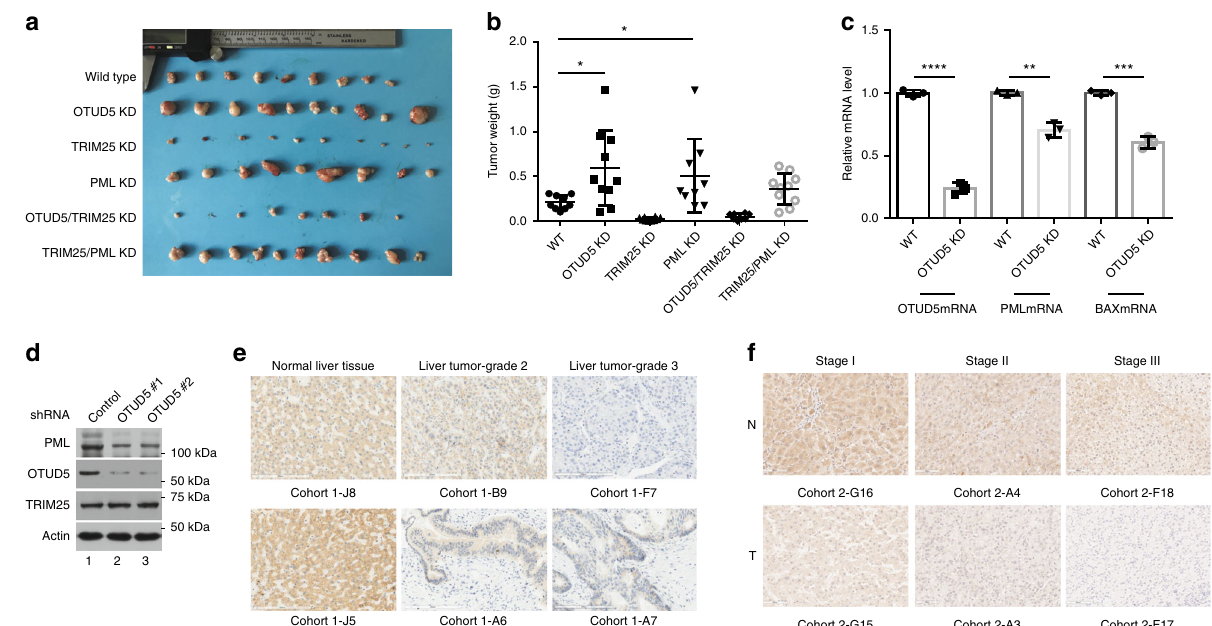
Fig. 7 The OTUD5-TRIM25 axis regulated tumor sphere formation of Hep3B cells. a Tumors derived from all groups are presented. b Tumor mass was measured in all groups and compared. Data are represented as means± SD from biological repeats. WT ( n = 9); OTUD5 KD ( n = 10); TRIM25 KD ( n = 10), PML KD ( n = 9), OTUD5/TRIM25 KD ( n = 8), TRIM25/PML KD ( n = 10). c The mRNA of the OTUD5-depleted xenografted cells was extracted and *** p = 0.0002 (BAX mRNA), two-tailed unpaired t -test. d The knockdown ef fi ciency of OTUD5 and the expression levels of TRIM25 and PML from